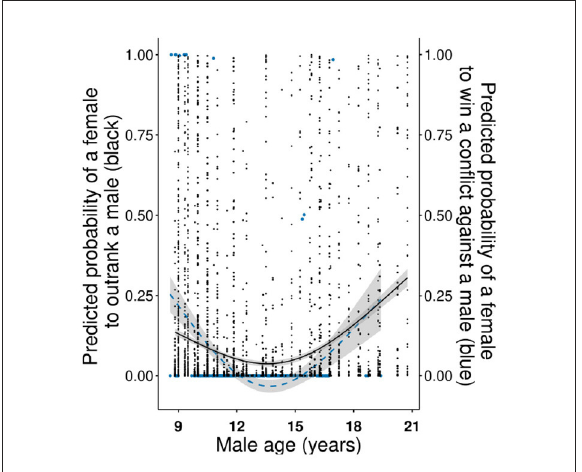
FIGURE2 Male age in relation to the probability for a female to outrank a male (black) and win a conflict against a male (blue-dashed line). The fitted values of the GLMMs are shown on the y-axes and shaded areas show 95% confidence intervals. For graphical purposes the quadratic term of male age is shown, although its effect on the probability to win an intersexual conflict was marginally non-significant ( p = 0.093).